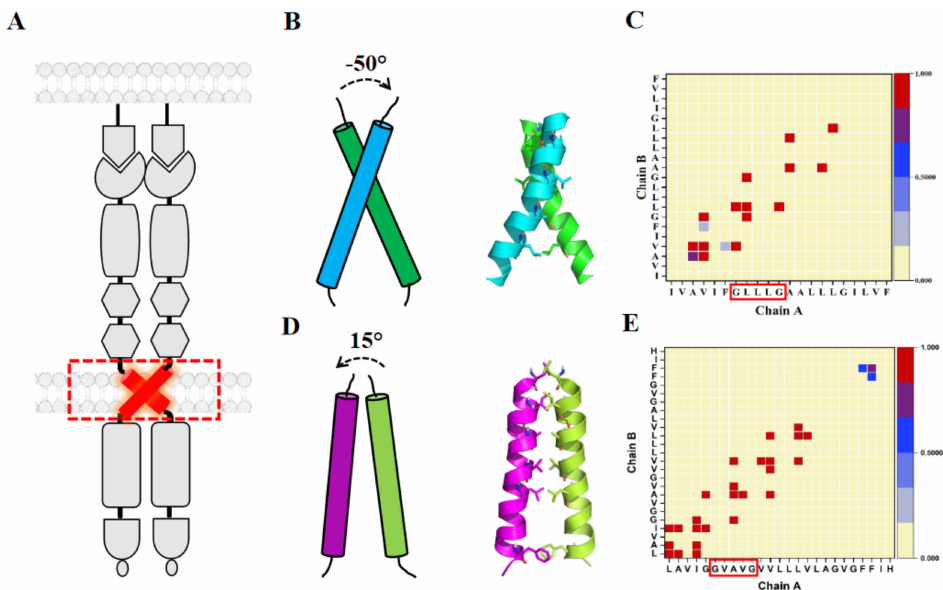
Figure 2. ( A ) Schematic representing lateral dimerization of Eph receptors shows the involvement of TM domains. ( B ) NMR structure of EphA1 TM dimer structure showing a right-handed configuration with an inter-helical angle of − 50 ◦ and the contact map interface of EphA1 ( C ). ( D ) NMR structure of EphA2 TM dimer structure showing a left-handed configuration with an inter-helical angle of 15 ◦ and the contact map interface of EphA2 ( E ). Contact maps are calculated with a cut off 4 Å considering all the ensembles of the NMR structure. The color (white to blue to red) indicates the fractional occupation of the contact (0 to 1). GXXXG motifs are highlighted in the contact map of EphA1 and EphA2 (for chain